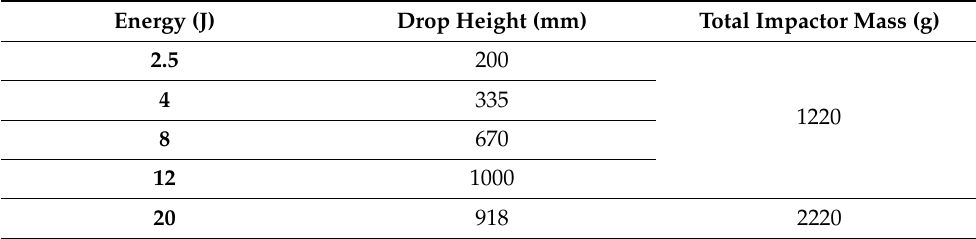
Table 1. Drop heights and impactor masses for impact